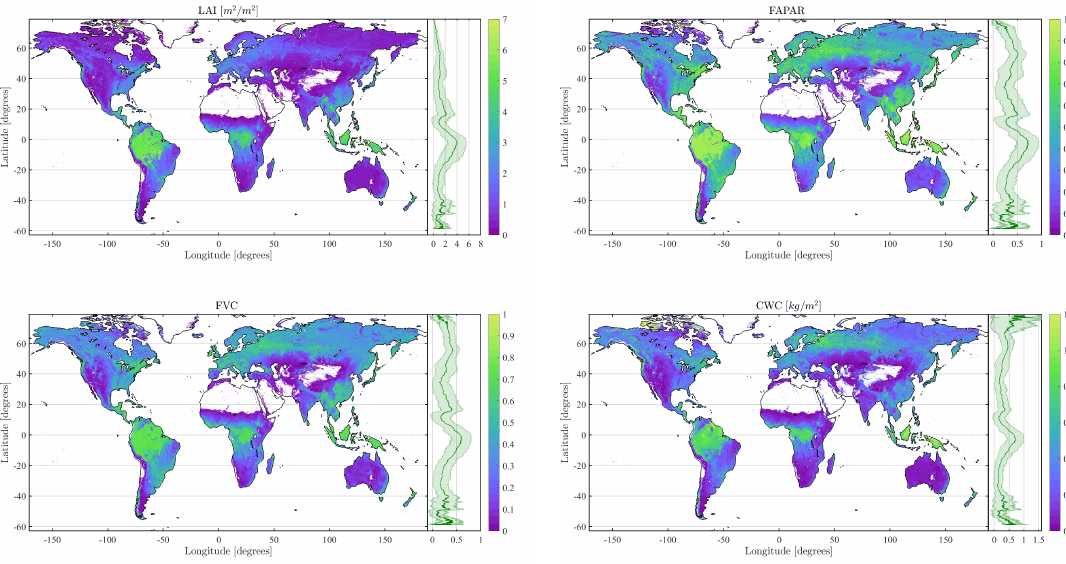
Figure 4. LAI, FAPAR, FVC, and CWC global maps and latitudinal transects corresponding to the mean values estimated by the proposed retrieval chain for the period 2010–2015.